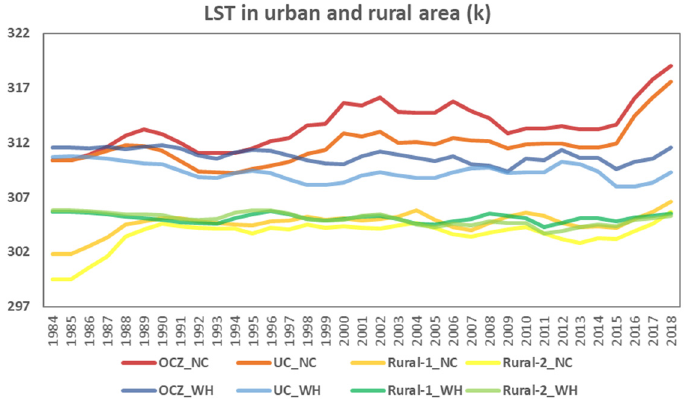
Figure 5. Temporal evolution for average LST in different area in Nanchang and Wuhan. The suffix “_NC” represents Nanchang; the suffix “_WH” represents Wuhan.